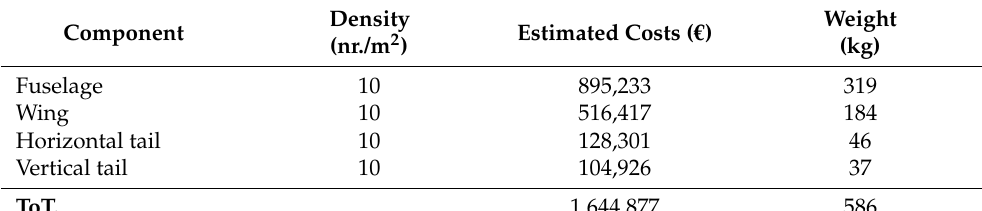
Table 12. SHM system characteristics with a lower sensors density.